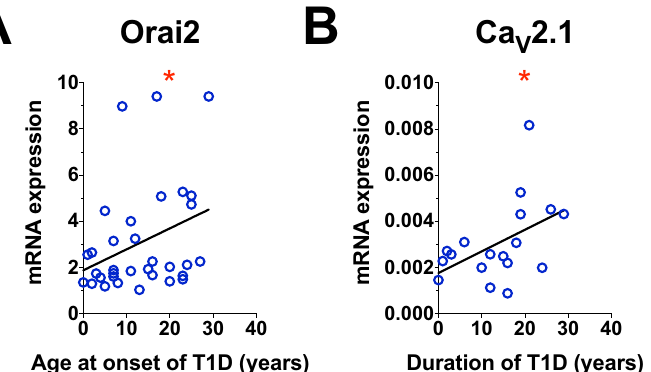
Fig 3. Correlation between the mRNA expression in PBMCs and demographic characteristics of type 1 diabetic donors. A. Correlation between ORAI2 and age at onset of type 1 diabetes. B. Correlation between Ca V 2.1 and duration of Type 1 diabetes. The correlation was accessed using non-parametric Spearman rank test. � indicates p value < 0.05.